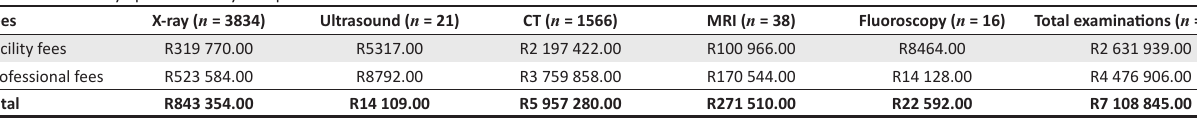
TABLE 3: Modality-specific facility and professional